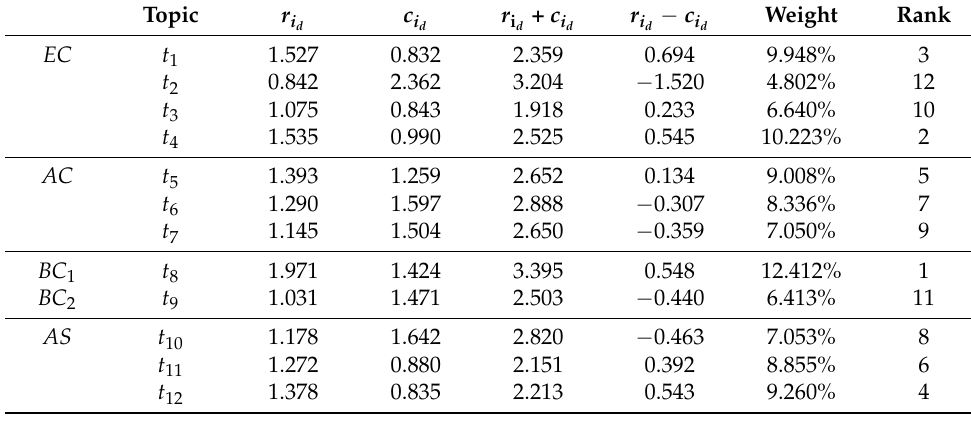
− c Table 8. r i i d , weight and ranking versus each topic. d